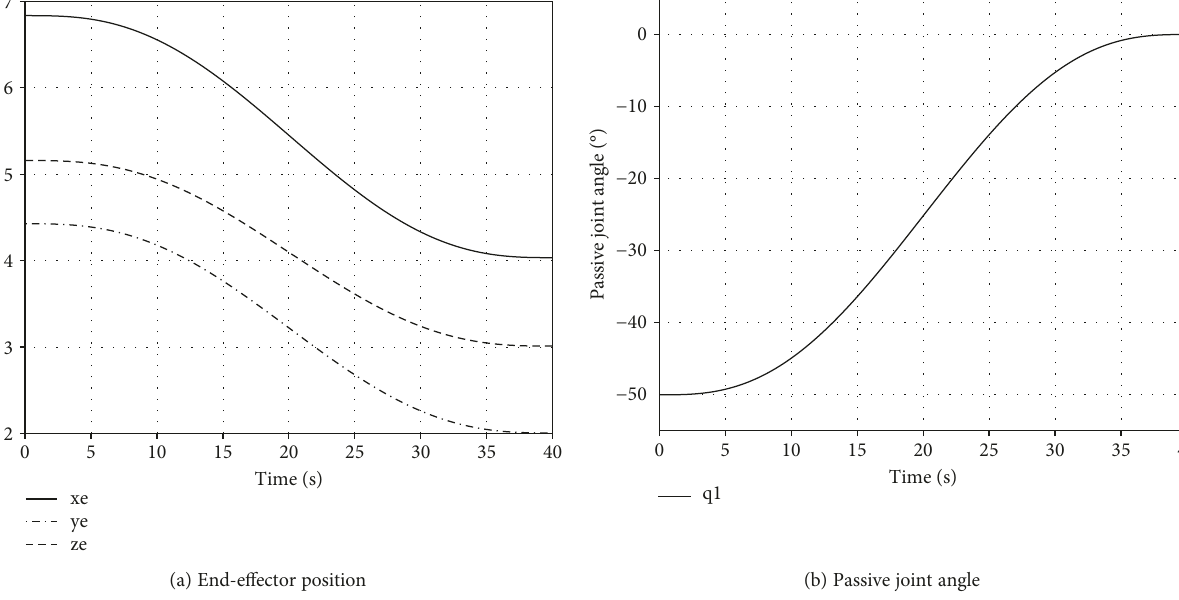
Figure 8: The variations of the end-e ff ector position and passive joint angle with execution of the combination